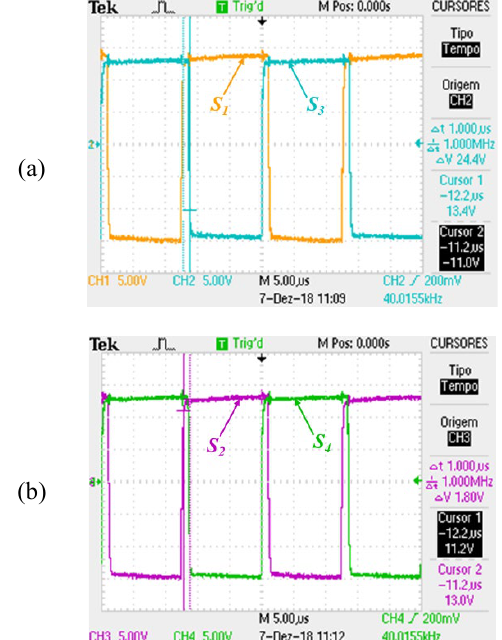
Figure 12. Experimental results of the proposed SAPF with reduced dc-link concerning the overlap-time of 1 µs between the gate signals of the semiconductors: (a) S 1 and S 3 ; (b) S 2 and S 4 .